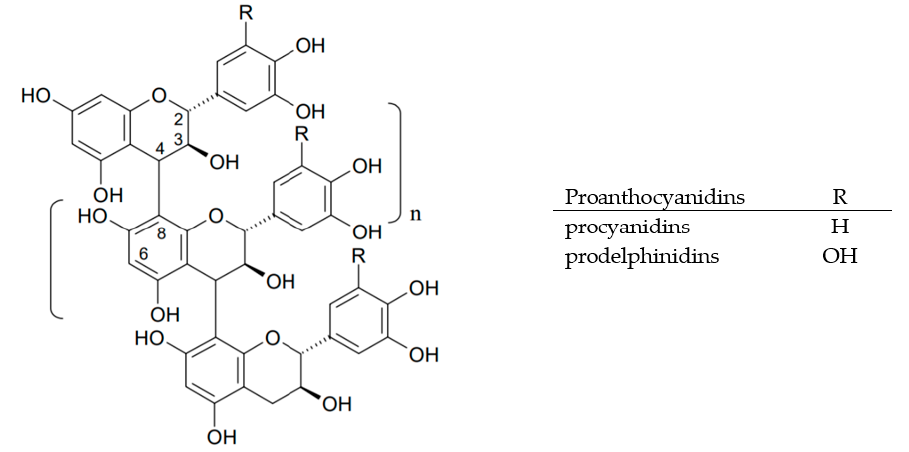
Figure 6. Structure of proanthocyanidins.